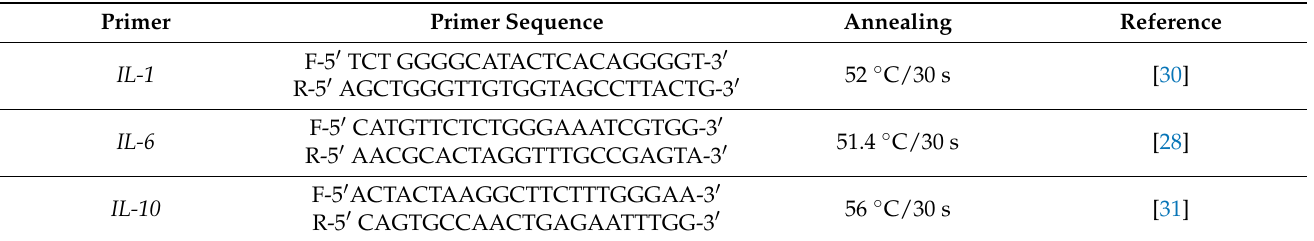
Table 1. RT-PCR Primers and Thermocycler conditions. Primer Primer